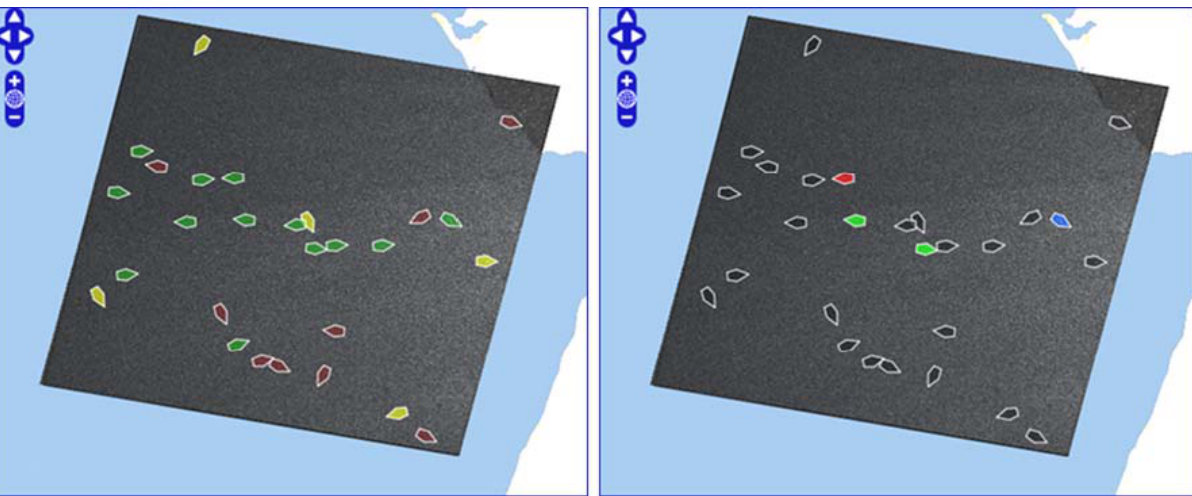
Figure 8. Examples of two types of reports that can be generated.